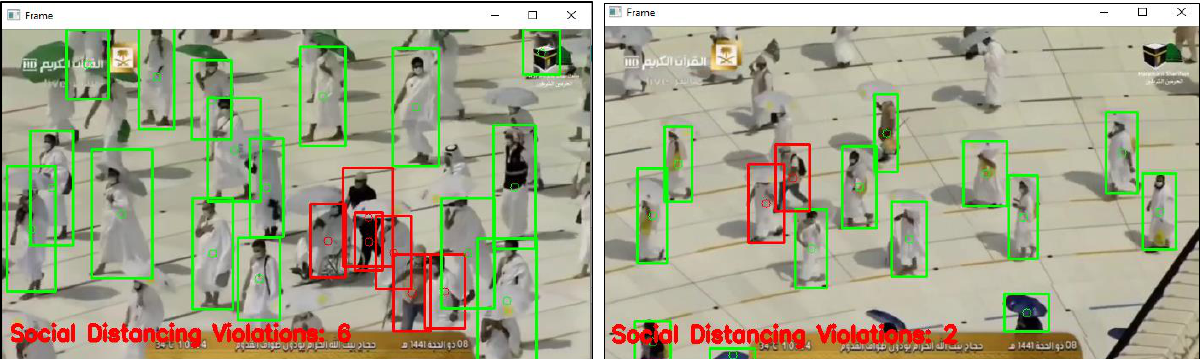
Figure 6. Result of the proposed model for Social Distancing Detection.